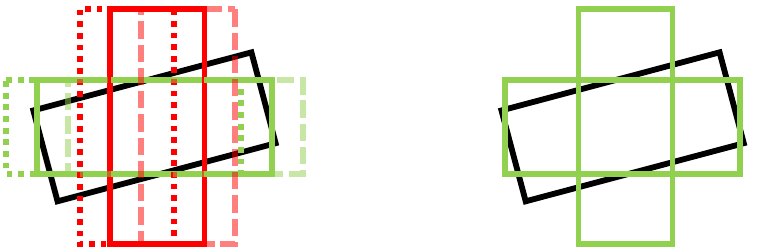
Figure 5. Target assigner for two rotation bin anchors from IoU labels ( left ) and Gaussian labels ( right ). Black, green and red bounding boxes correspond to ground truth, and positive and nega- tive